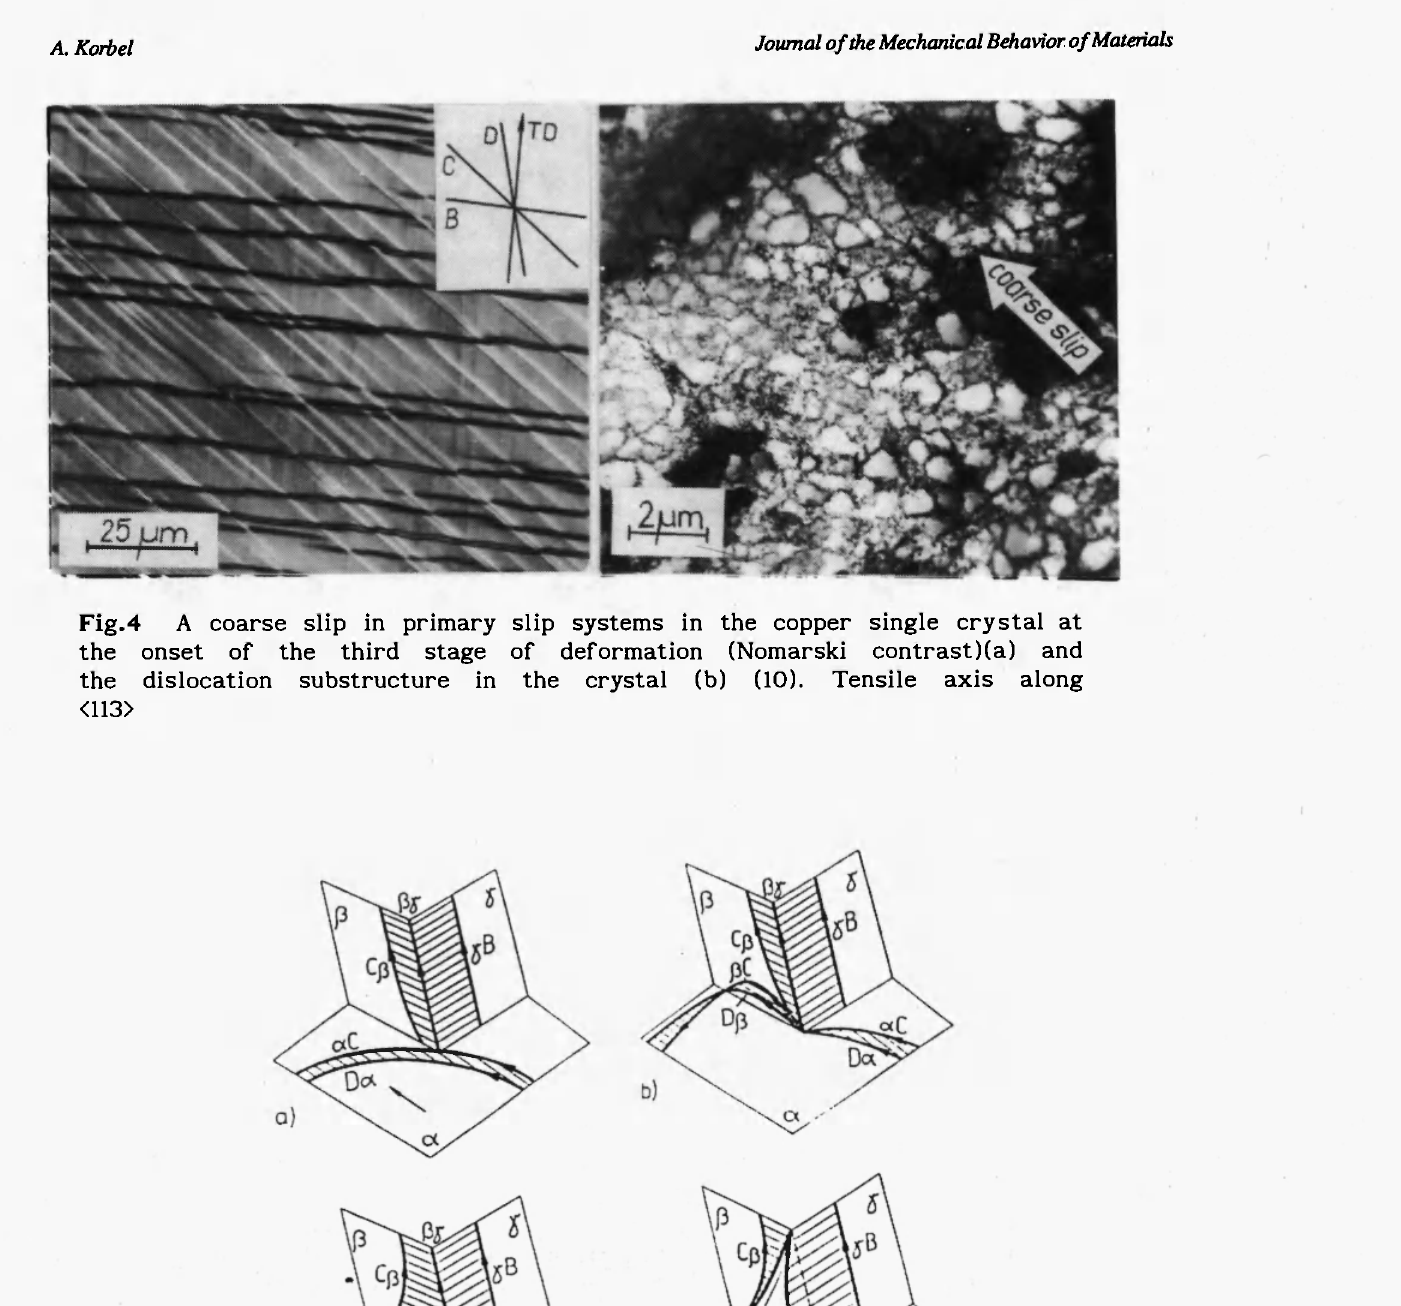
Fig.5 The model of unlocking of L-C barrier Cß-ßy-γΒ in result of the interaction with critical plane dislocation CD.